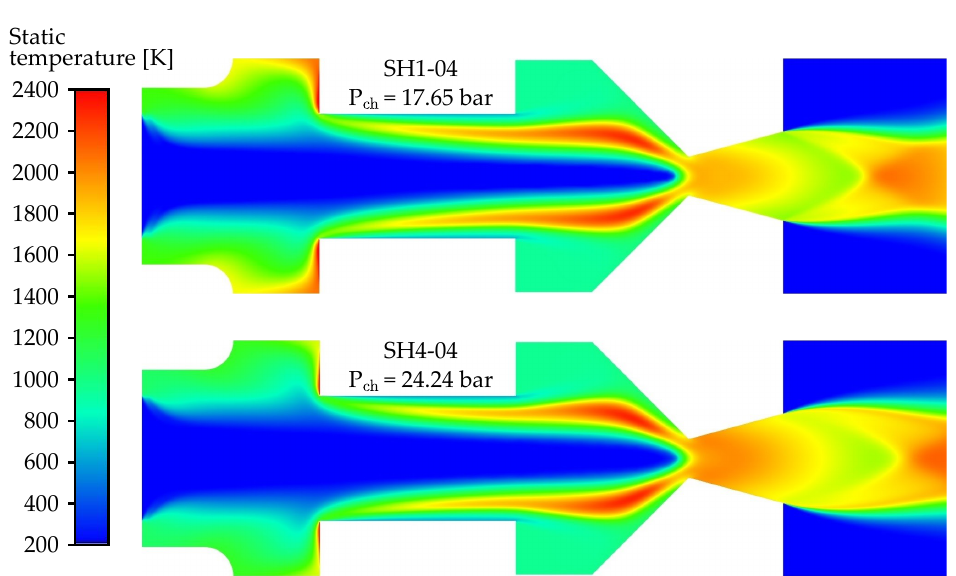
Figure 11. Static temperature field for cases SH1-04 and SH4-04.